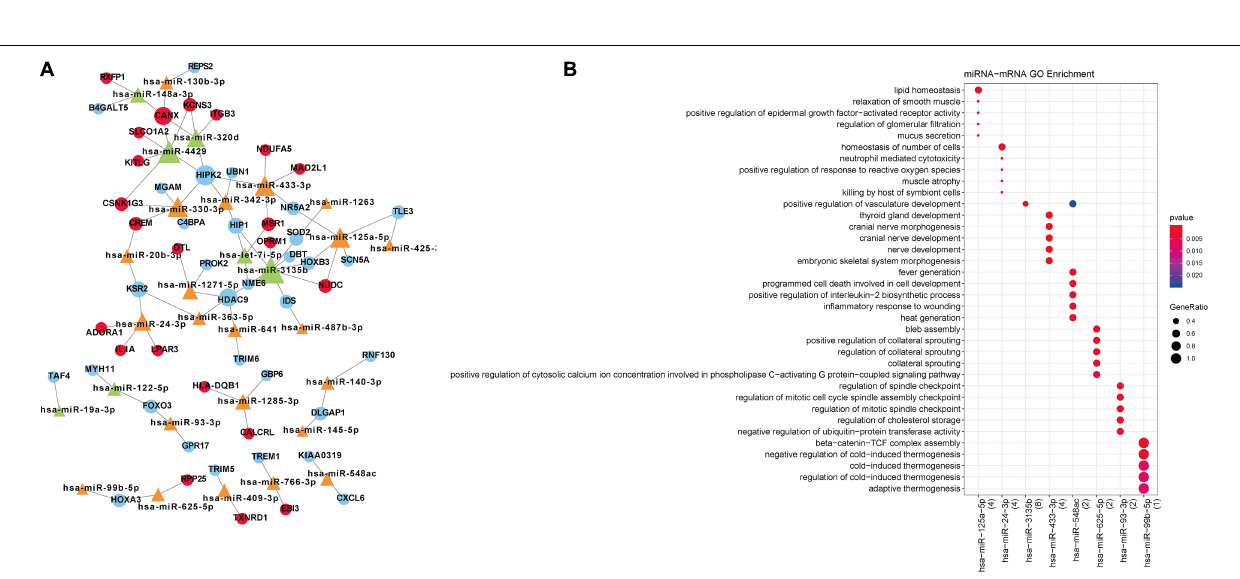
Frontiers in Integrative Neuroscience |